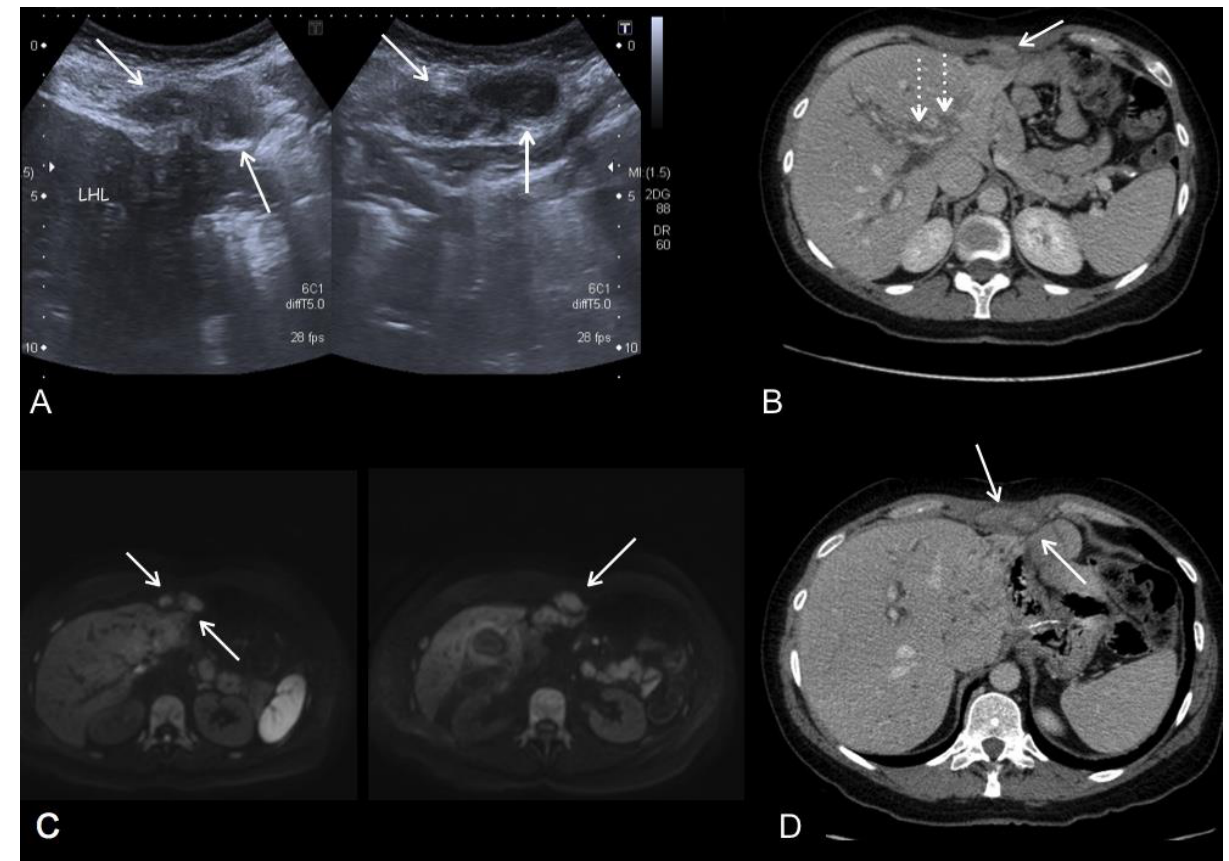
Figure 7. Imaging follow-up of a 50-year-old woman who underwent total gastrectomy for diffuse gastric adenocarcinoma. US ( A ), portal phase contrast-enhanced CT axial ( B , D ) and MR-DWI b800 ( C ) images show an epigastric implant (arrows) invading the abdominal wall. Disease extended to the left intersegmental fissure and continued along the falciform ligament, reaching the left hepatic lobe and the abdominal wall. Note the right periportal tumour dissemination (dotted arrows).